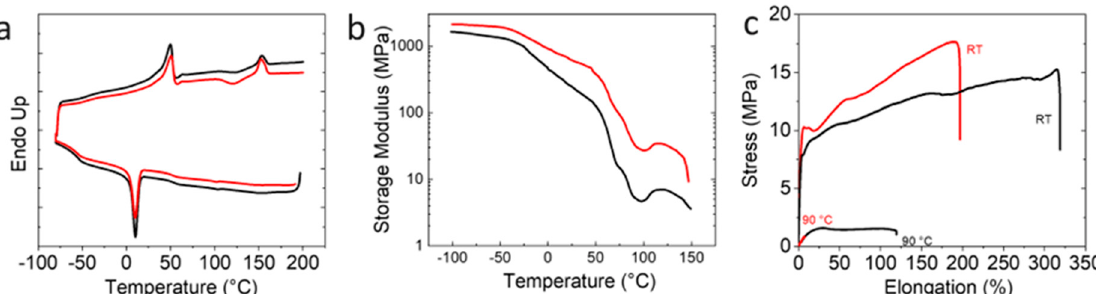
Figure 6. ( a ) DSC thermograms of neat blend and blend composite ( b ) Storage modulus at varied temperatures ( c ) Uniaxial tensile testing of the neat blend polymer and composite at room temperature (RT) and 90 °C. PEU70PLA30 (black line), PEU70PLA30MWCNT14 (red line).